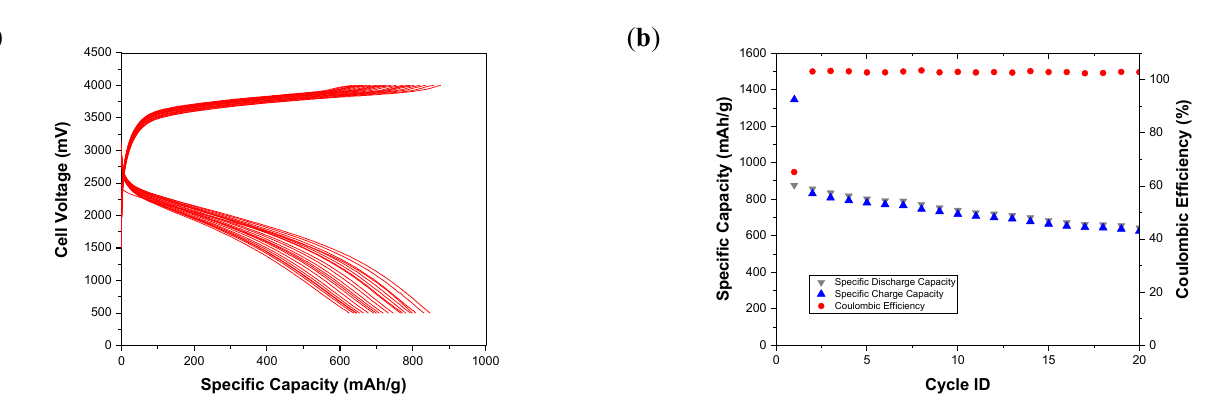
Figure 12. Electrochemical performance of Si 3 N 4 @Si@Cu//LFP full cell at 200 mA/g: ( a ) GCD profile and ( b ) cycling stability.